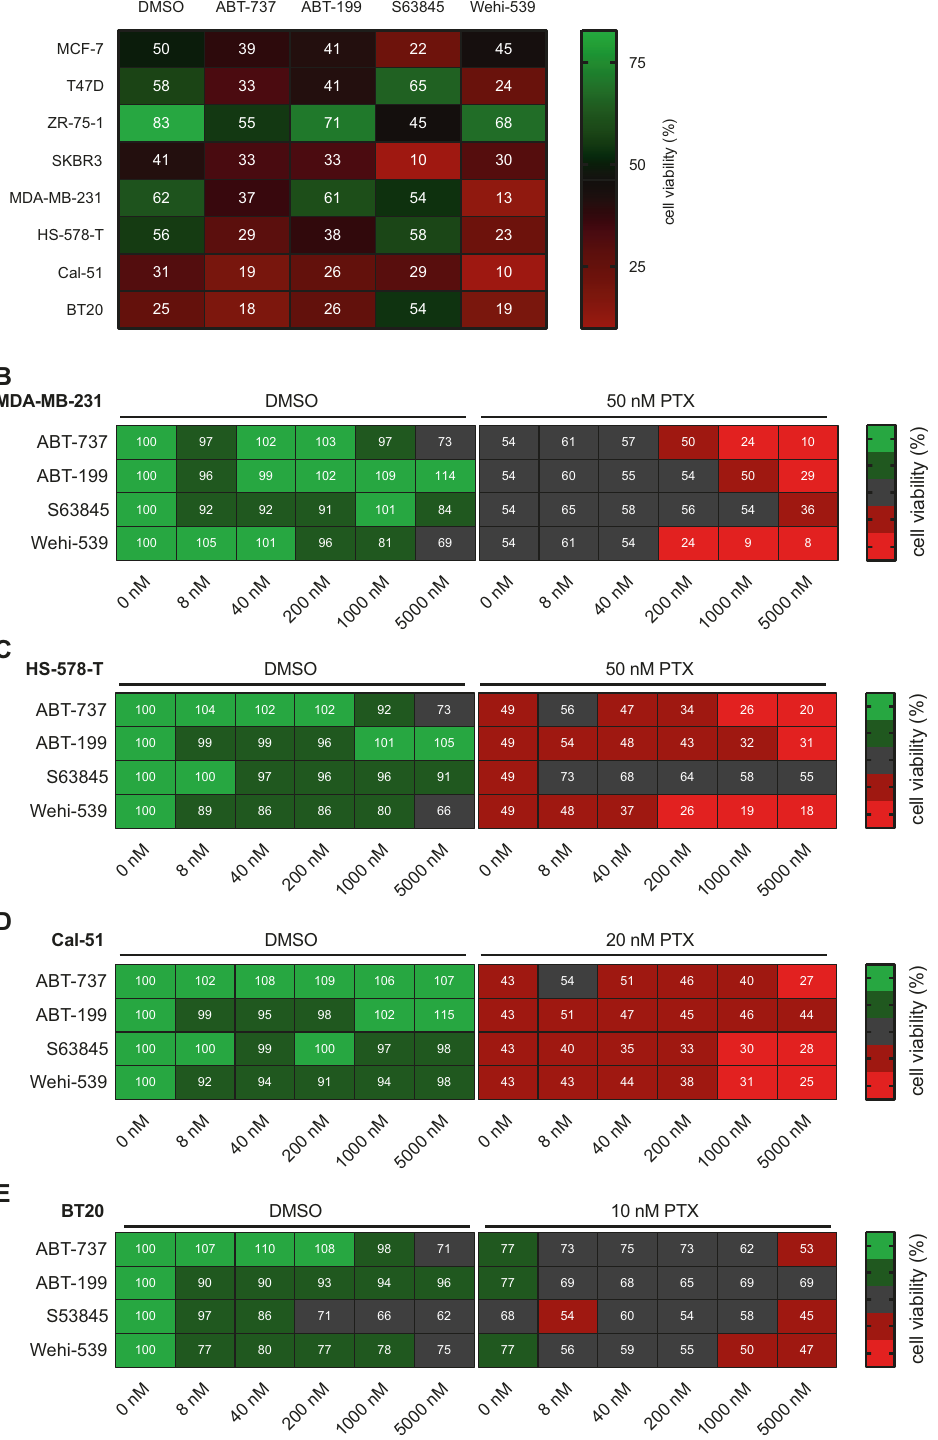
Fig. 4 Paclitaxel increases the sensitivity towards BH3 mimetics. A The indicated cell lines were treated with 50 nM paclitaxel alone or in combination with 1 µM of BH3mimetics for 48 h. B – E TNBC cell lines were treated with graded concentrations of BH3-mimetics in combination with a predetermined fi xed concentration of paclitaxel for 48 h. Metabolic activity was calculated by setting the metabolic activity in relation to the DMSO control. Heatmaps show mean values of metabolic activity ranging from 0 to 100% as assessed by MTT-assay. A All cell lines ( n = 3 – 4), B MDA-MB-231 ( n = 6), C HS-578-T ( n = 4), D Cal-51 ( n = 6), E BT20 ( n =